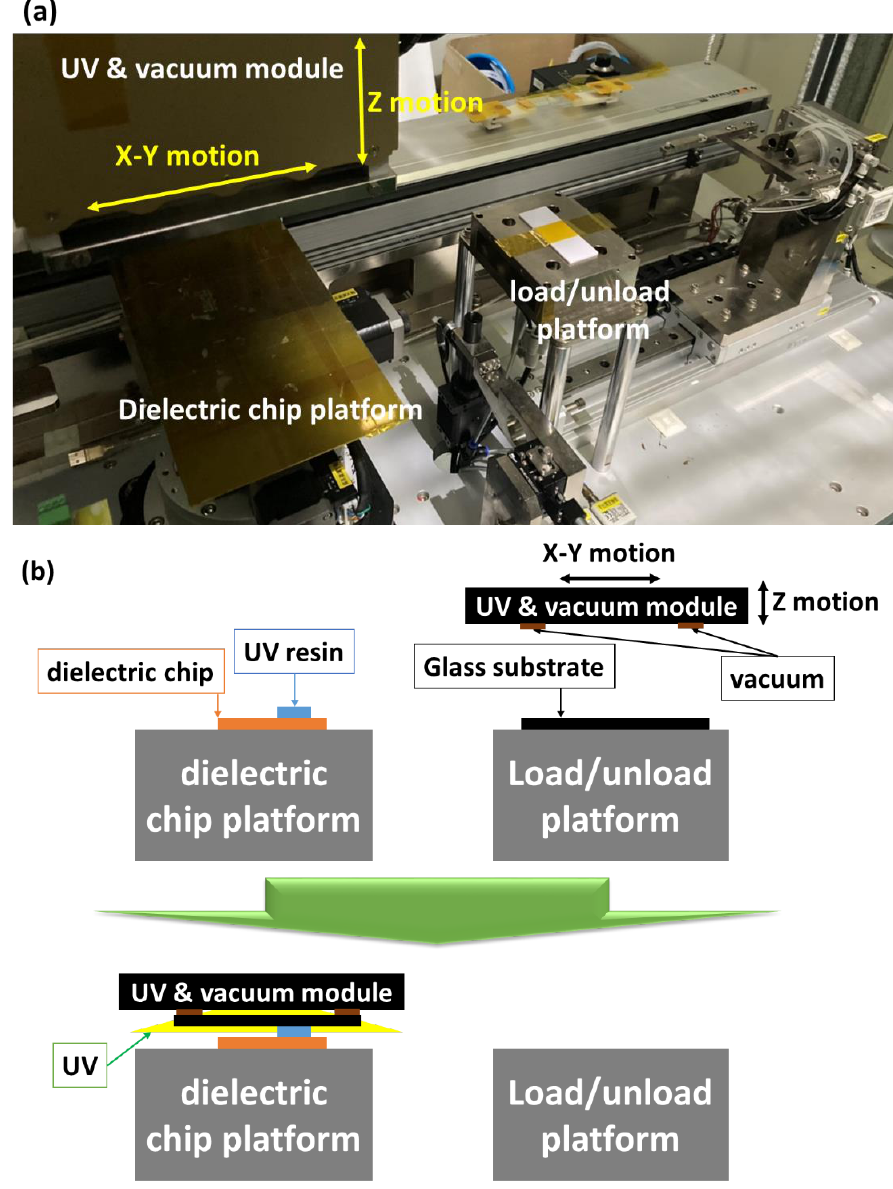
Figure 2. ( a ) Experimental set up of this research. ( b ) Procedure of the dielectric